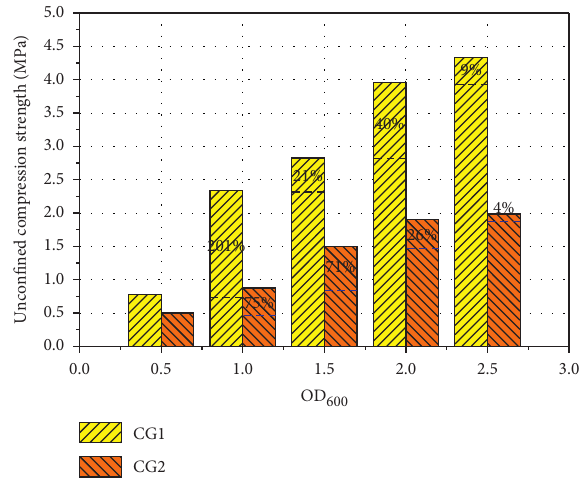
Figure 9: Unconfined compression strength (UCS) of standard silica sand (CG1) and Aeolian sandy soil